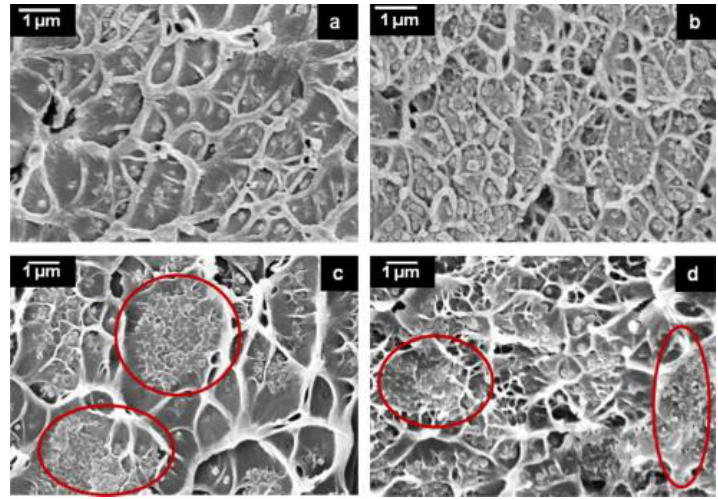
Figure 2. Dispersion of ZIF-8 by direct ( a , b ) and indirect ( c , d ) sonication of 10 wt.% ( a , c ) and 25 wt.% ( b , d ) loading in Matrimid [51], with copyright permission from © 2012 Elsevier. Carter et al. [54] loaded 10% ZIF-8 with particle size of 95 nm in Matrimid and prepared two